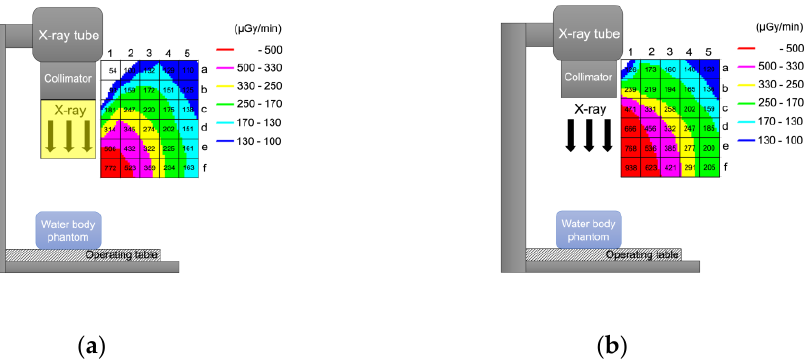
Figure 3. Change in scattered radiation distribution when a short curtain is used. ( a ) When a short curtain is used. ( b ) When a short curtain is not used. Numbers in the grid square represent the measured dose rate ( μGy/min).